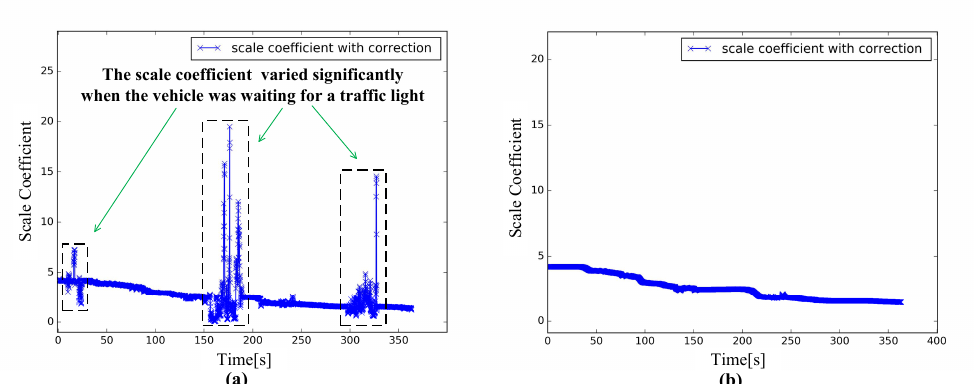
Figure 7. ( a ) shows the result of scale estimation method without considering the effect of vehicle motion state; ( b ) indicates the better result of our proposed method. [Color figure can be viewed at